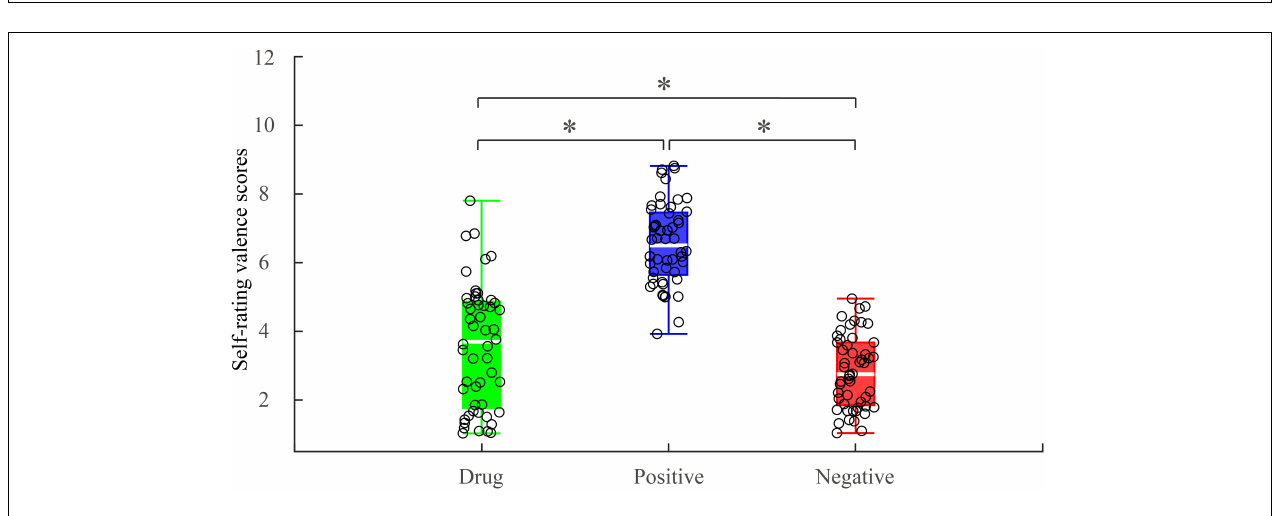
FIGURE 2 | Self-rating valence scores under different experimental conditions. ∗ p <